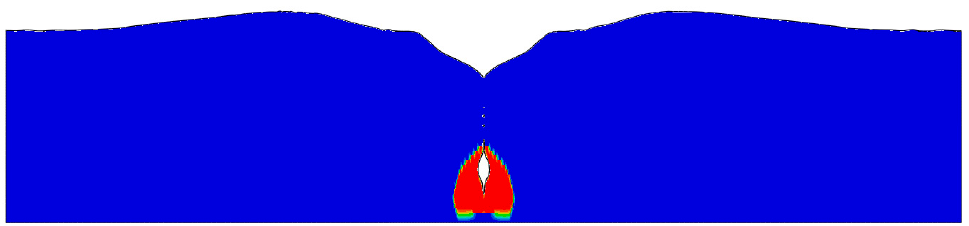
Figure 11. Results of simulating forced replacement method ( H = 3.0 m).